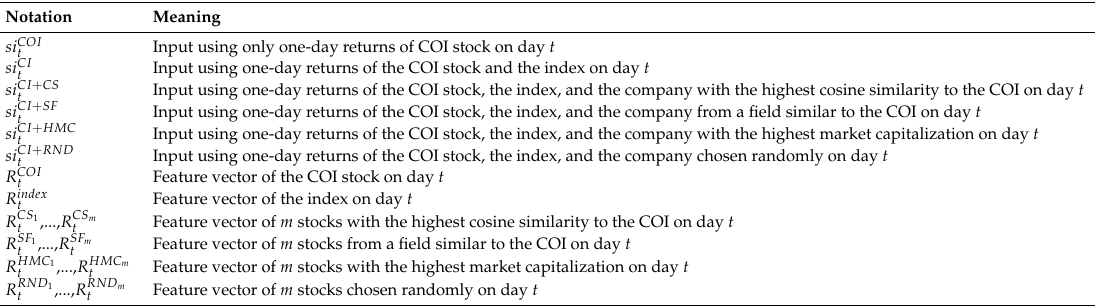
Table 3. Definitions of